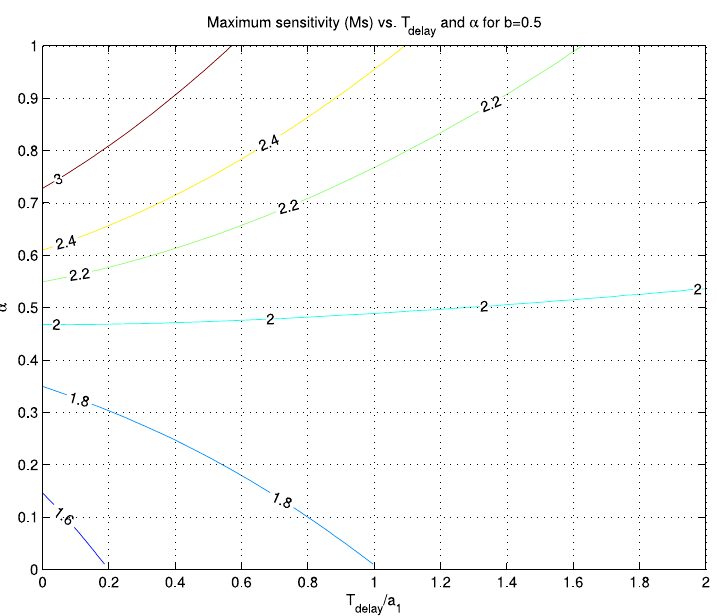
Figure 5. Closed-loop maximum sensitivity (M S ) for G ( s ) and controller parameter b = 0 at different values of process parameters T delay and α.